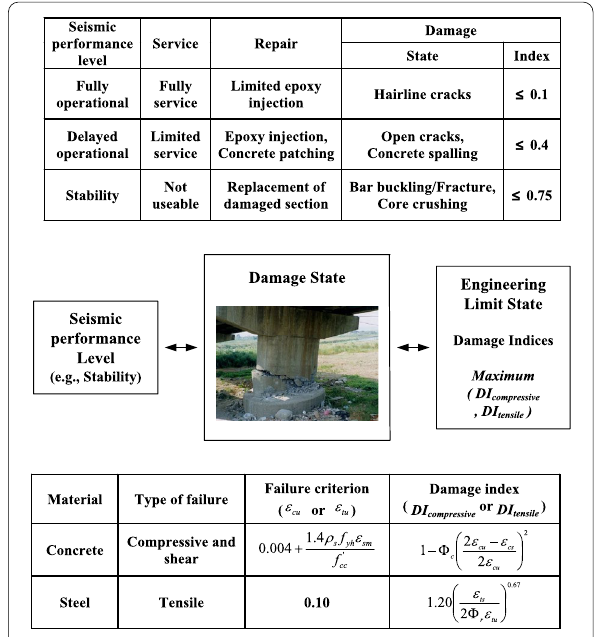
Fig. 3 Seismic performance assessment using a damage index (Kim, 2019).